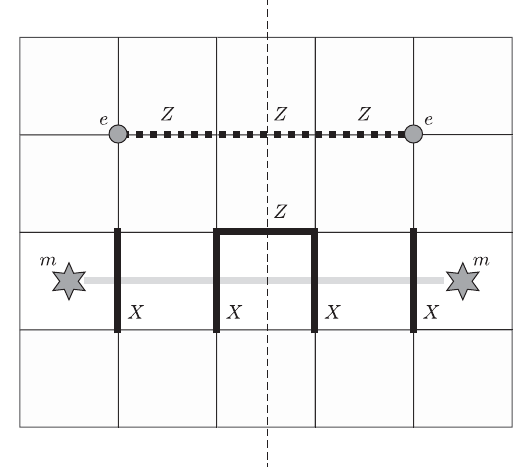
FIG. 6. String operators, in the modified toric code model, creating a reflection-symmetric pair of e particles (top) and m particles (bottom). Operators in the e string ( m string) are indicated by thick dotted (solid) lines. The m string, whose path is shown by the light gray line, is decorated with a single τ z operator at the reflection axis (dashed